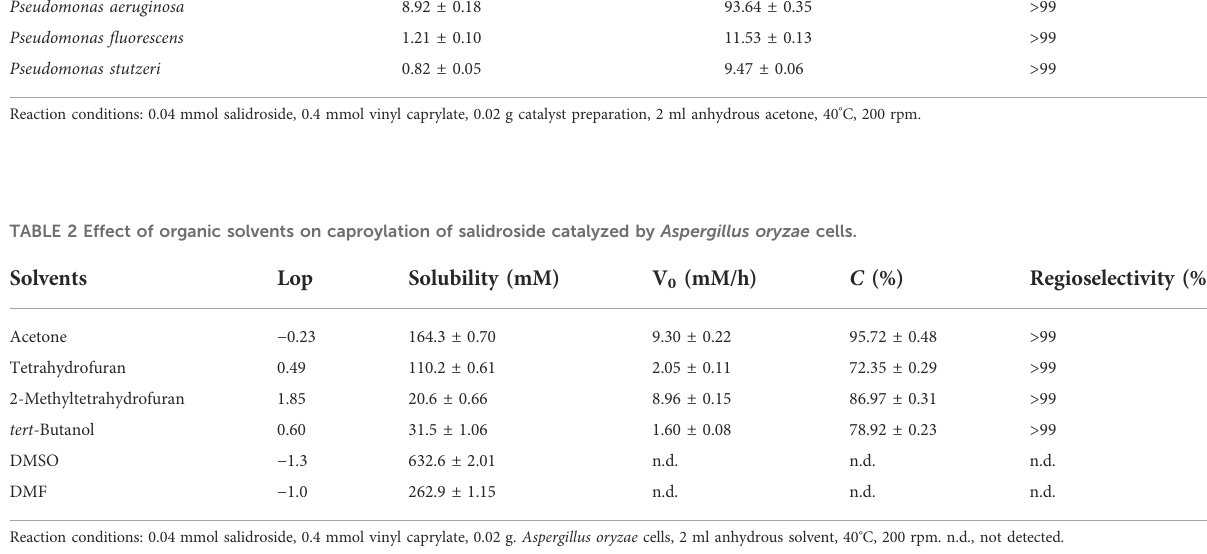
TABLE 1 Regioselective caproylation of salidroside catalyzed by the whole cells. Strains V 0 (mM/h) C (%) Rhizopus oryzae